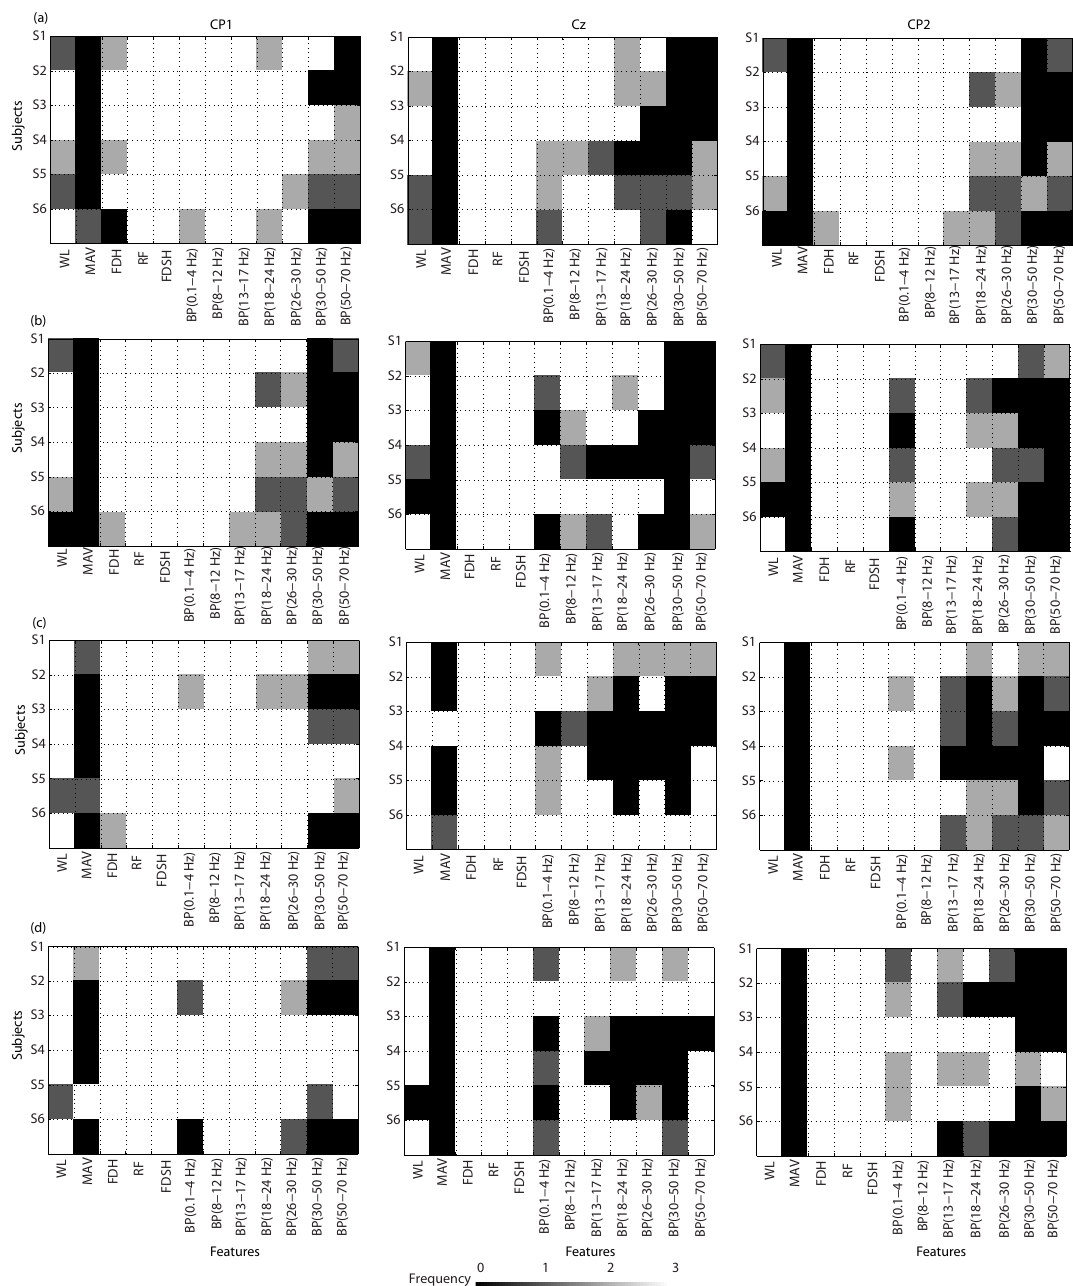
Figure 5. Representation of the BCI performance for the selected features, applying Ad WAR, WAR, Ad LAR and LAR filters. The rows present, for the six subjects, the selected features on CP1, Cz and CP2. Rows ( a ) Ad WAR; ( b ) WAR; ( c ) Ad LAR; ( d )